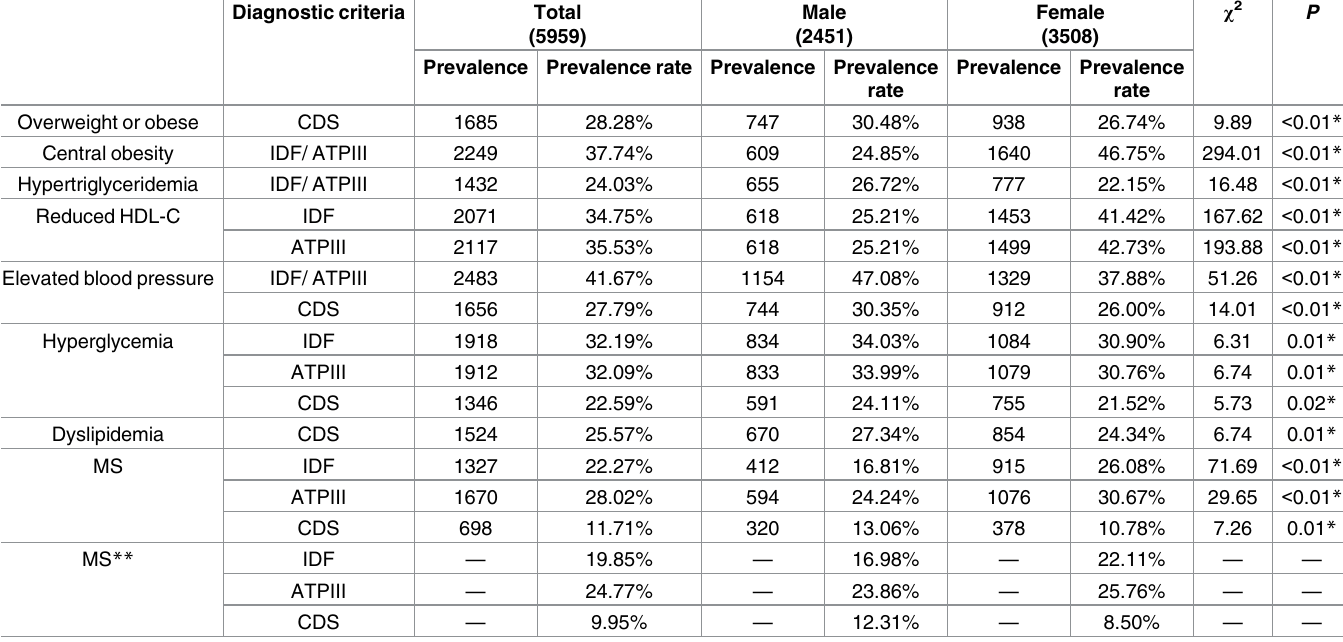
Table 3. The prevalent rates of the components of MS by gender (according to the IDF, ATP Ⅲ , and CDS